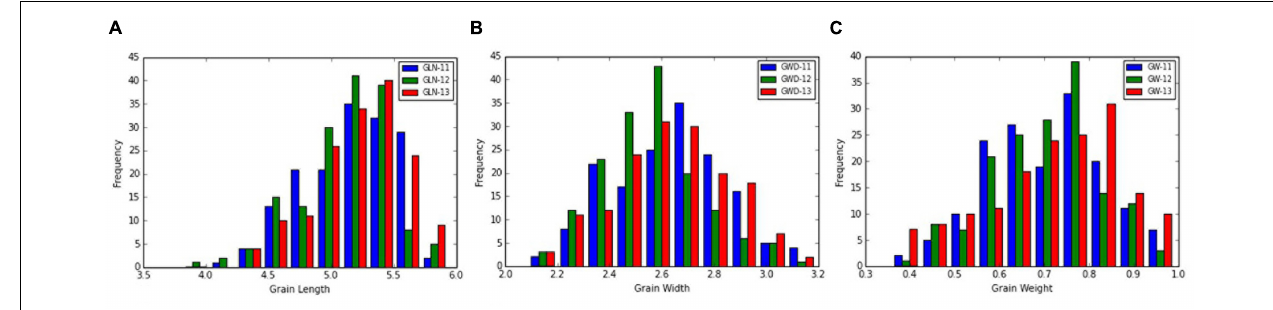
FIGURE 1 | Phenotypic distribution for grain (A) length, (B) width, and (C) weight in the year 2011, 2012, and 2013.